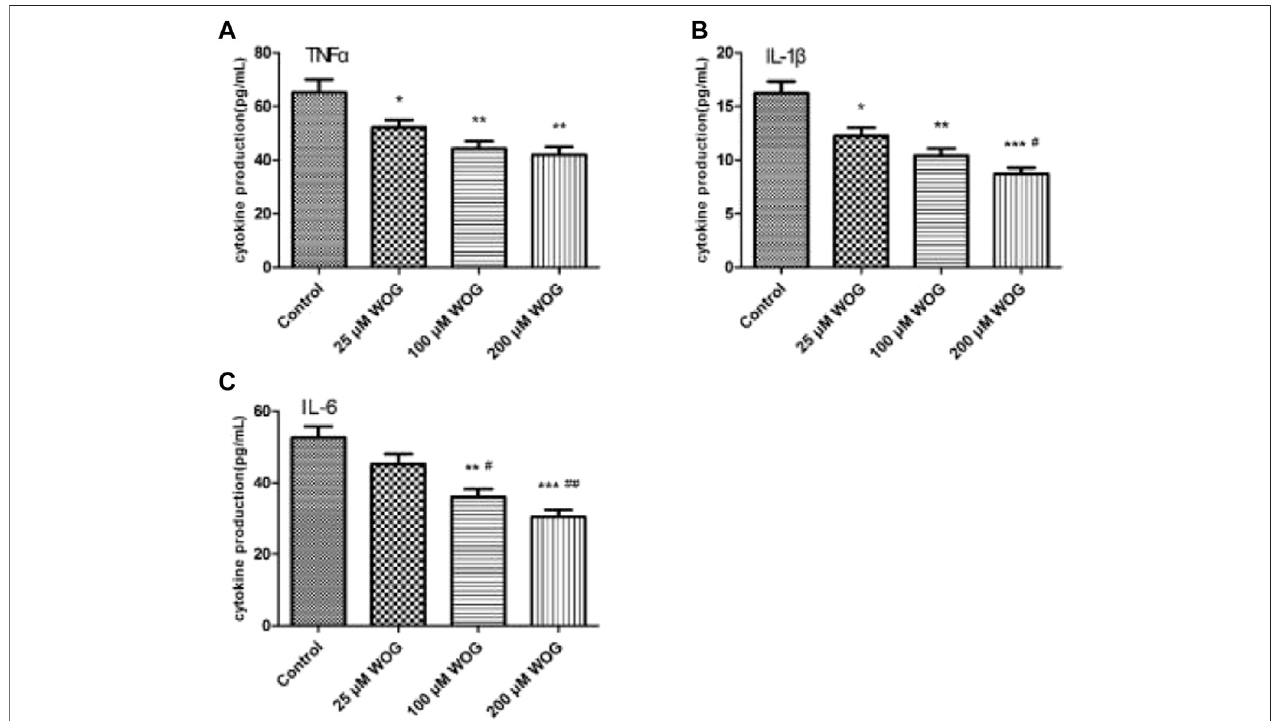
FIGURE 6 | The expression of TNF- α (A) , IL-1 β (B) , and IL-6 (C) was inhibited by Wogonin in U251 cells.